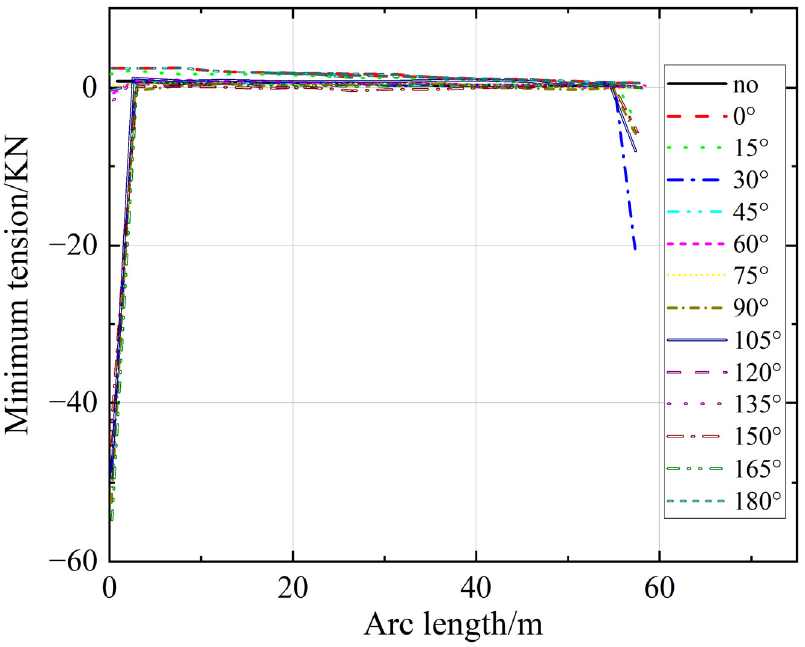
Figure 16. The minimum tension of the crane wire along the length direction.